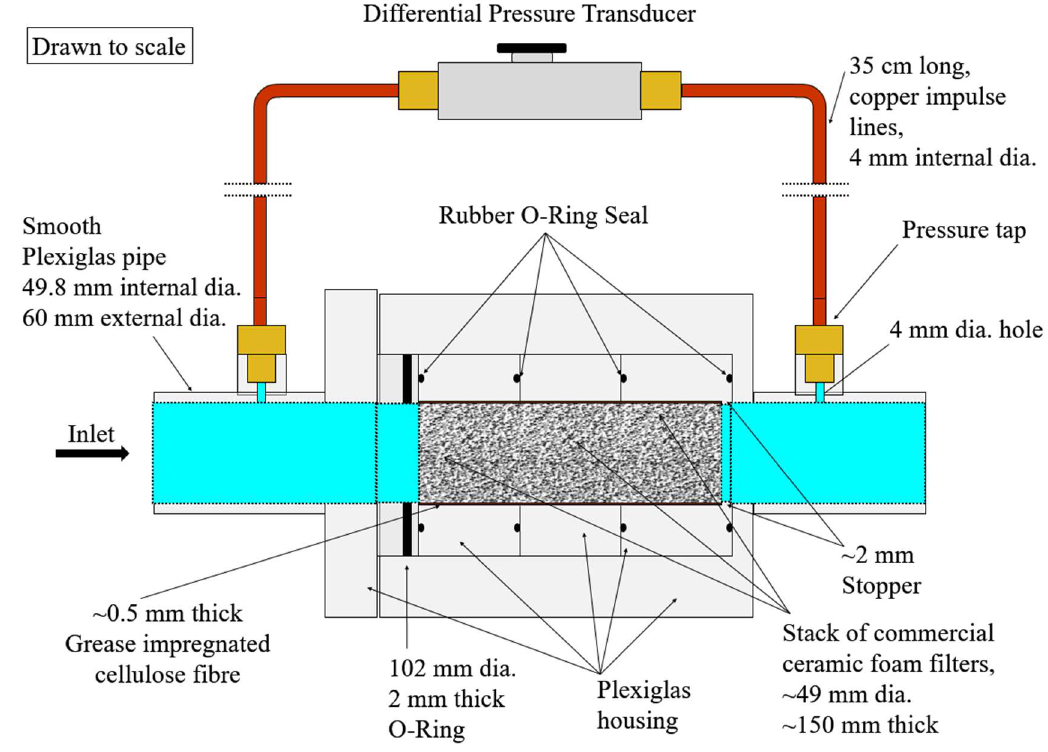
Figure 1. Experimental apparatus. Table 1. Filter dimension and porosity values data from